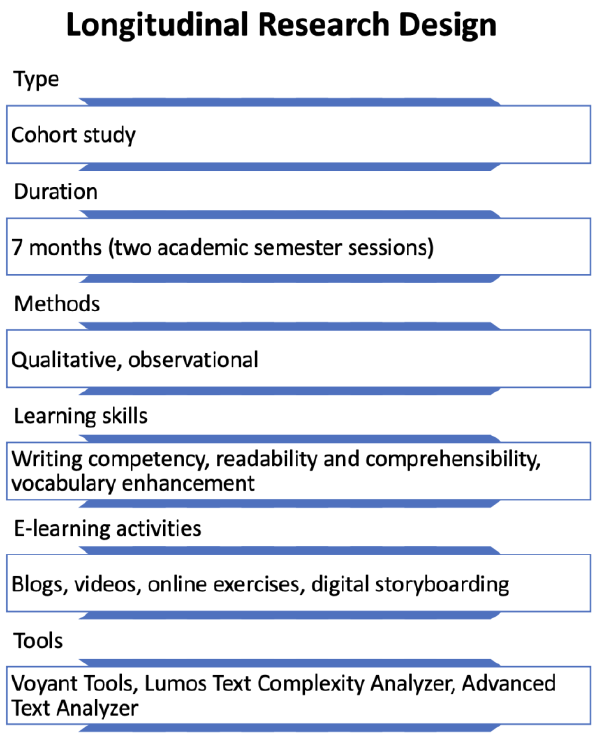
Figure 1. Research Figure 1. Research design.